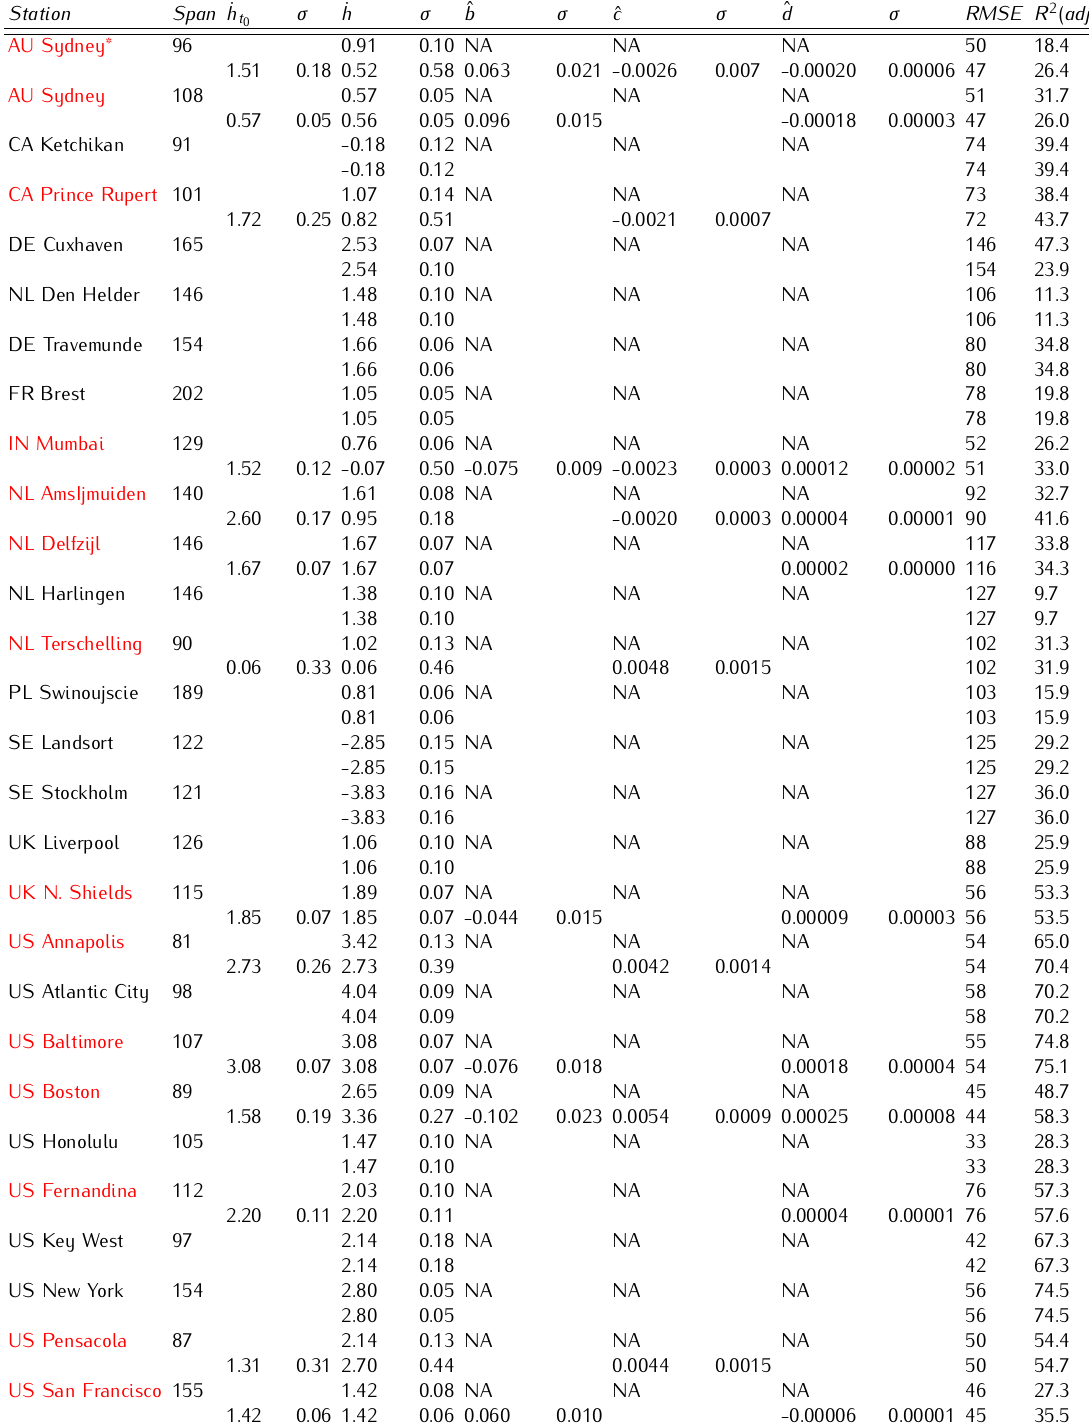
Table 1. The solution statistics for no-acceleration (the first lines) and variable-acceleration models. Records are in years, velocities in mm/yr followed by their standard errors. The RMSE is in mm, and adjusted R 2 values are in percent. Stations with statistically significant variable-acceleration parameters ( p < 0 . 05 ) are shown in red. NA: Not Applicable. No PGR corrections were applied. Estimates for the reference heights, amplitudes of semi-annual, annual and node periods are not